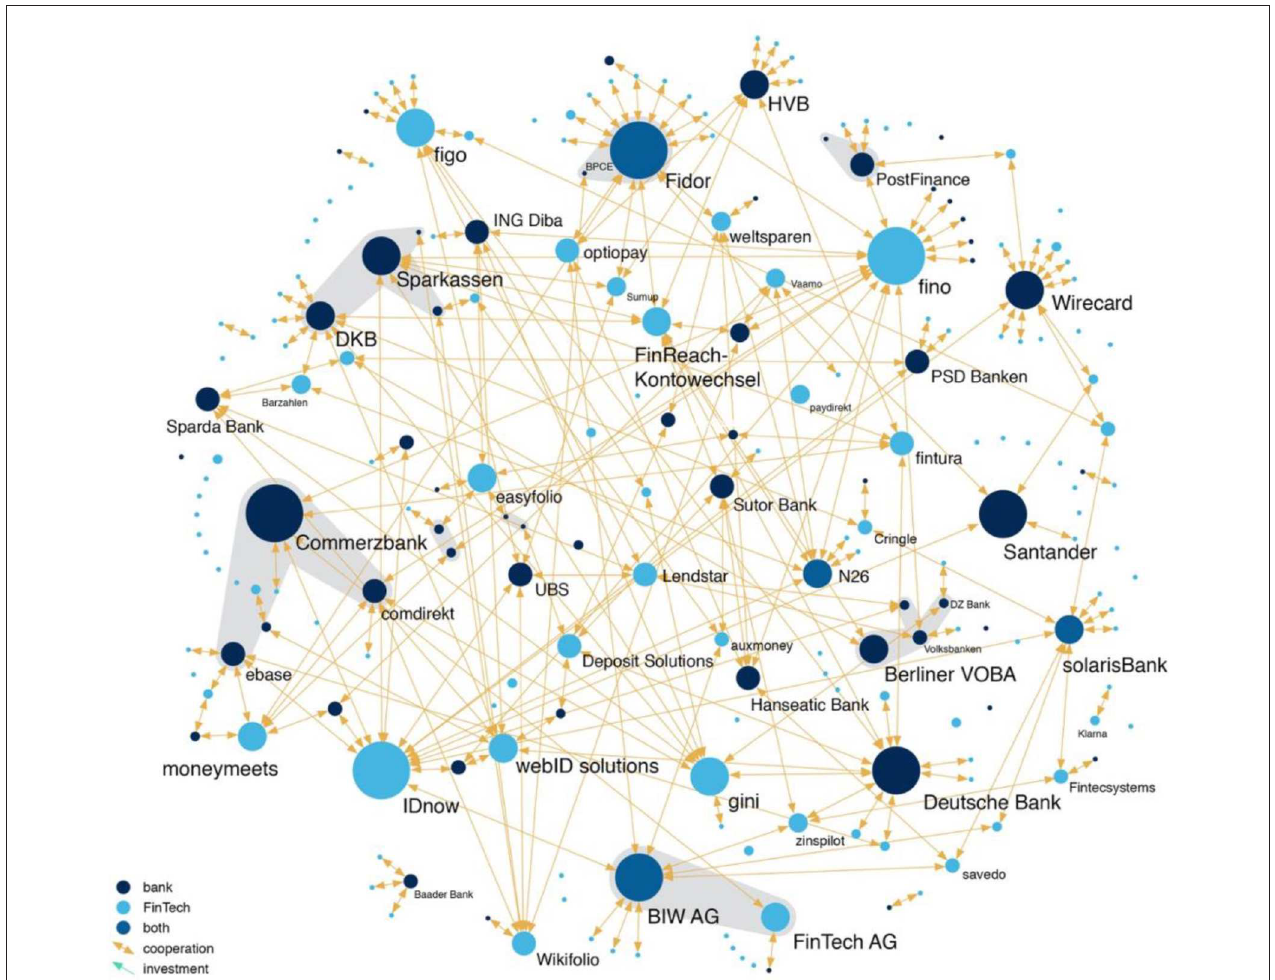
FIGURE 3 | Bank and FinTech